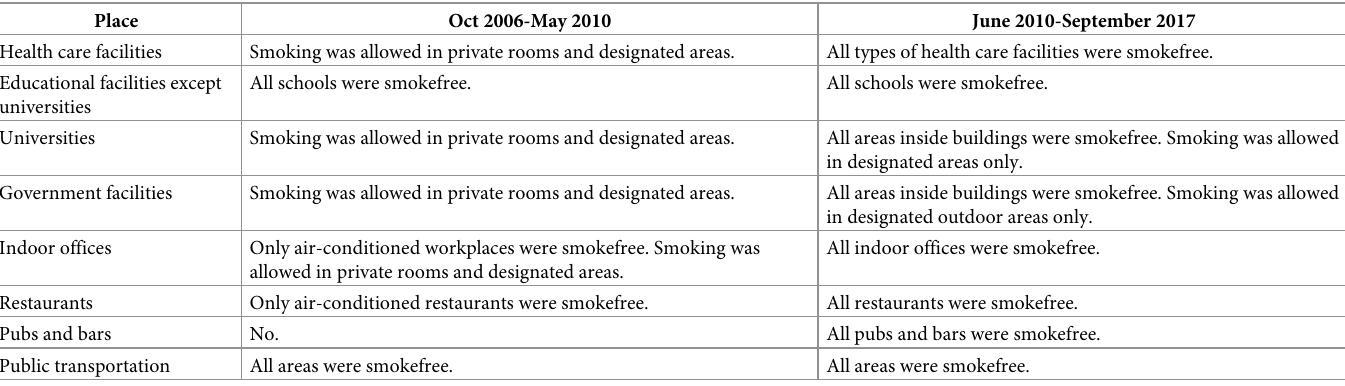
Table 1. Smoke restrictions before and after June 2010 [39, 40].